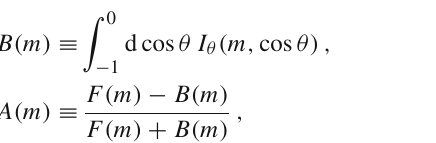
ent double-Regge contributions to the amplitudes and will be addressed in Sects. 5 and